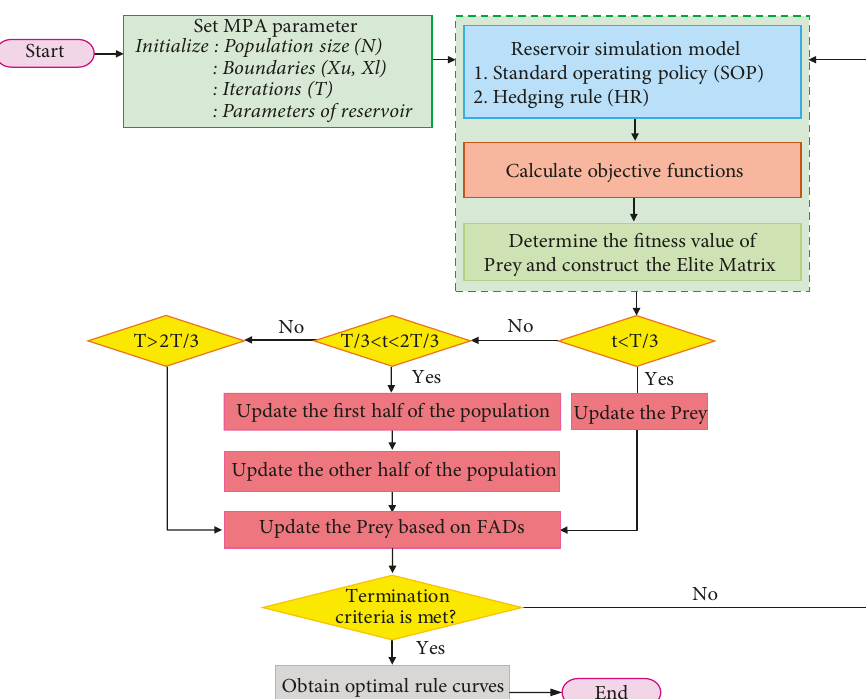
Figure 5: Application of MPA and reservoir simulation model for searching optimal rule curves.